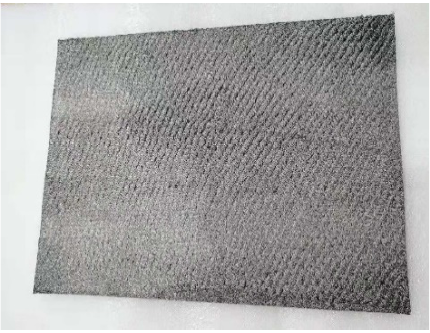
Figure 5. Plate-like entangled metallic wire material specimen.